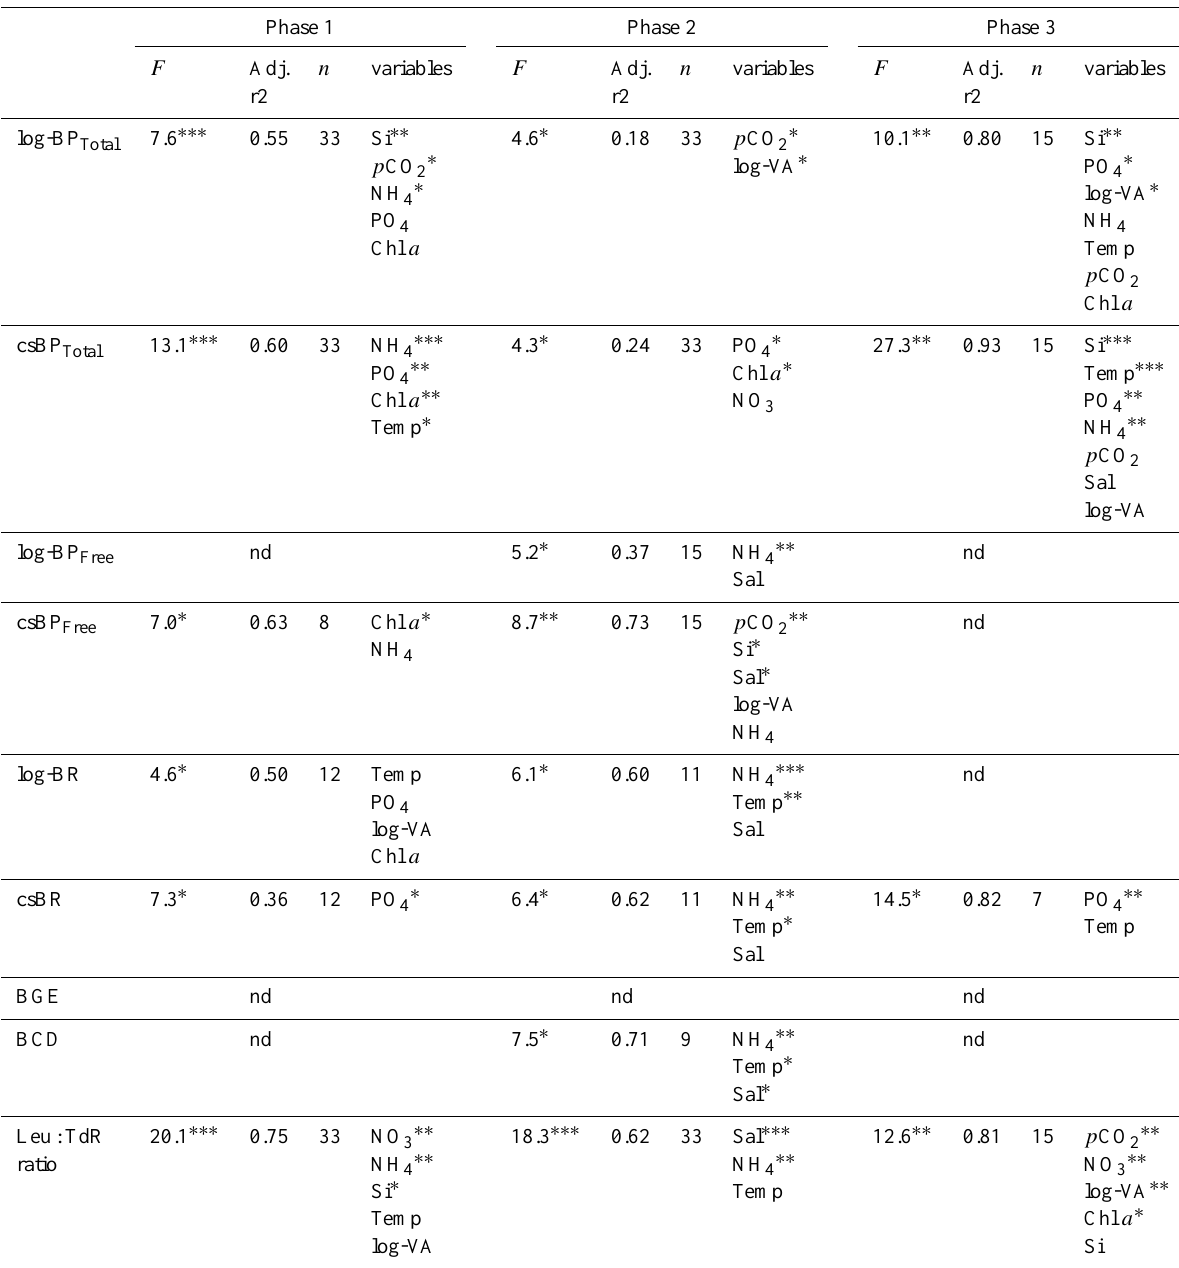
Table A1. Stepwise multiple regression analysis of log-BP Total , csBP Total , log-BP Free , csBP Free , log-BR, csBR, BGE, BCD and